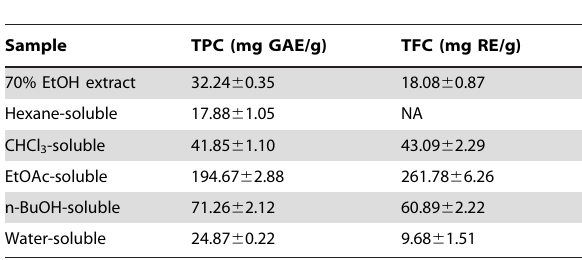
Table 2. Total Phenolic Content (TPC) and Total